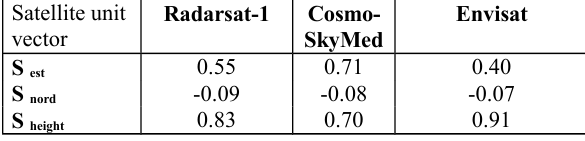
Table 4. Line of Sight Parameters